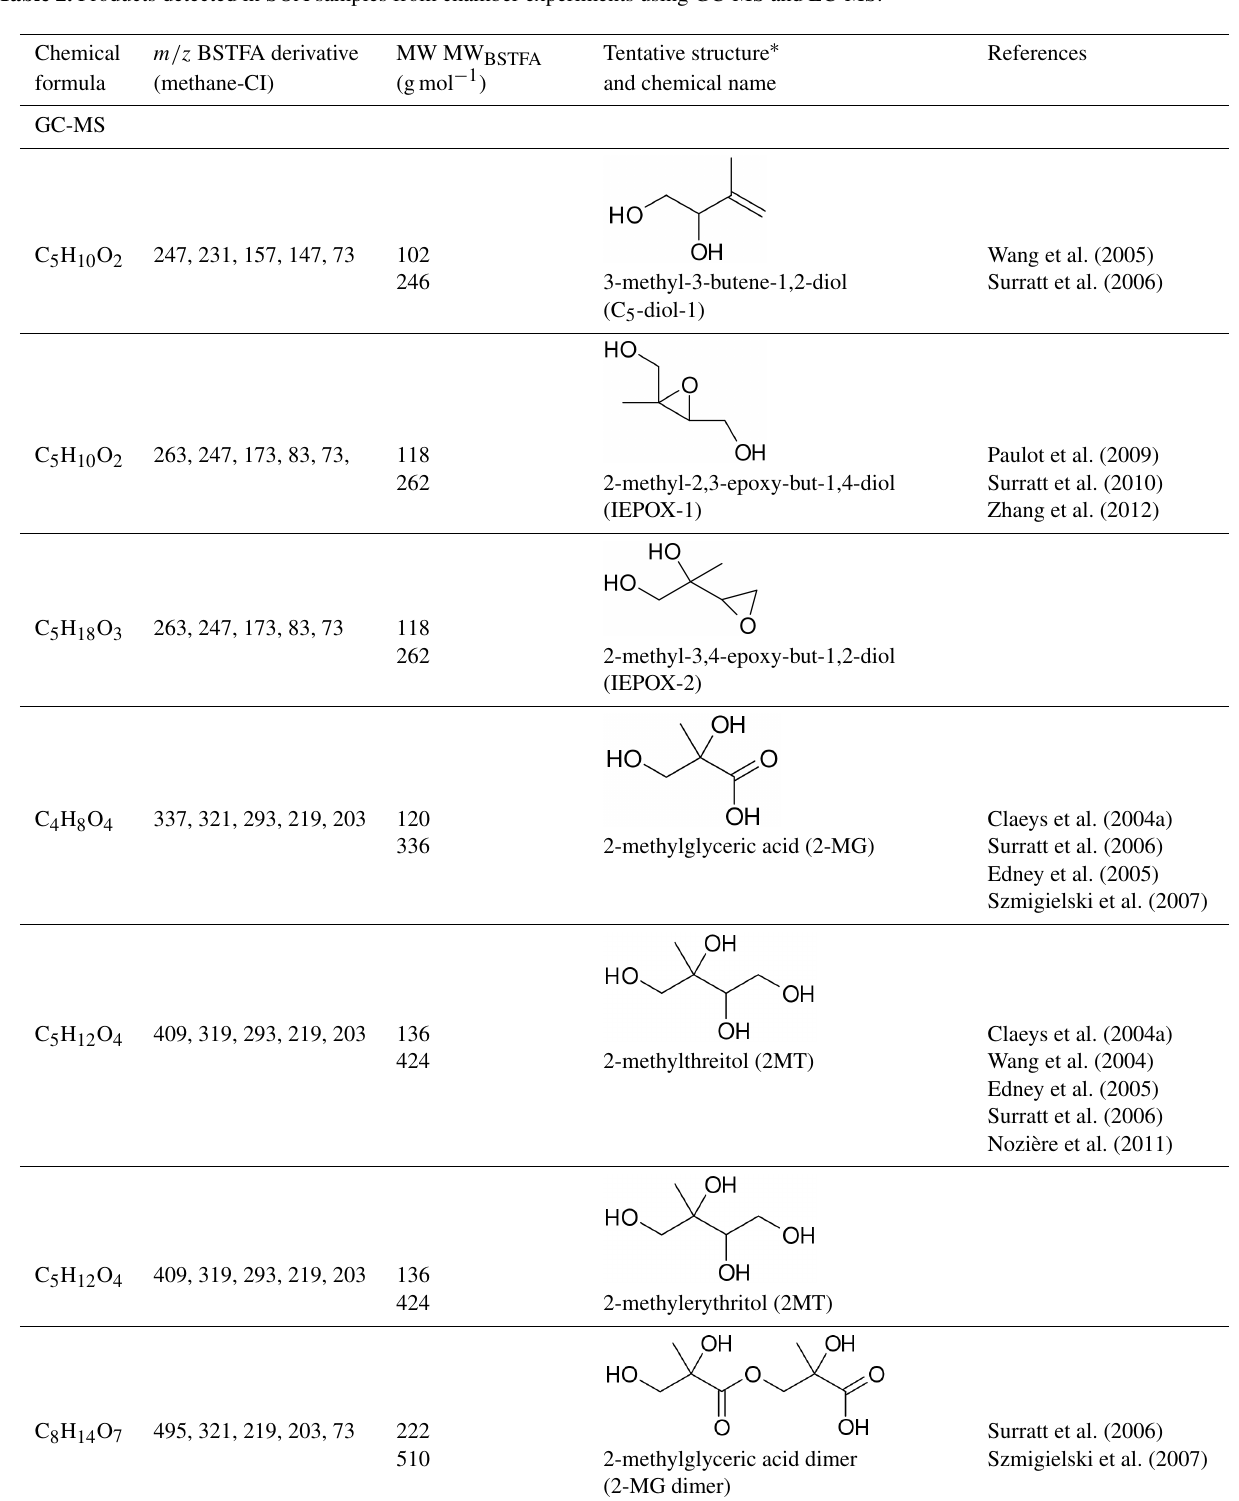
Table 2. Products detected in SOA samples from chamber experiments using GC-MS and